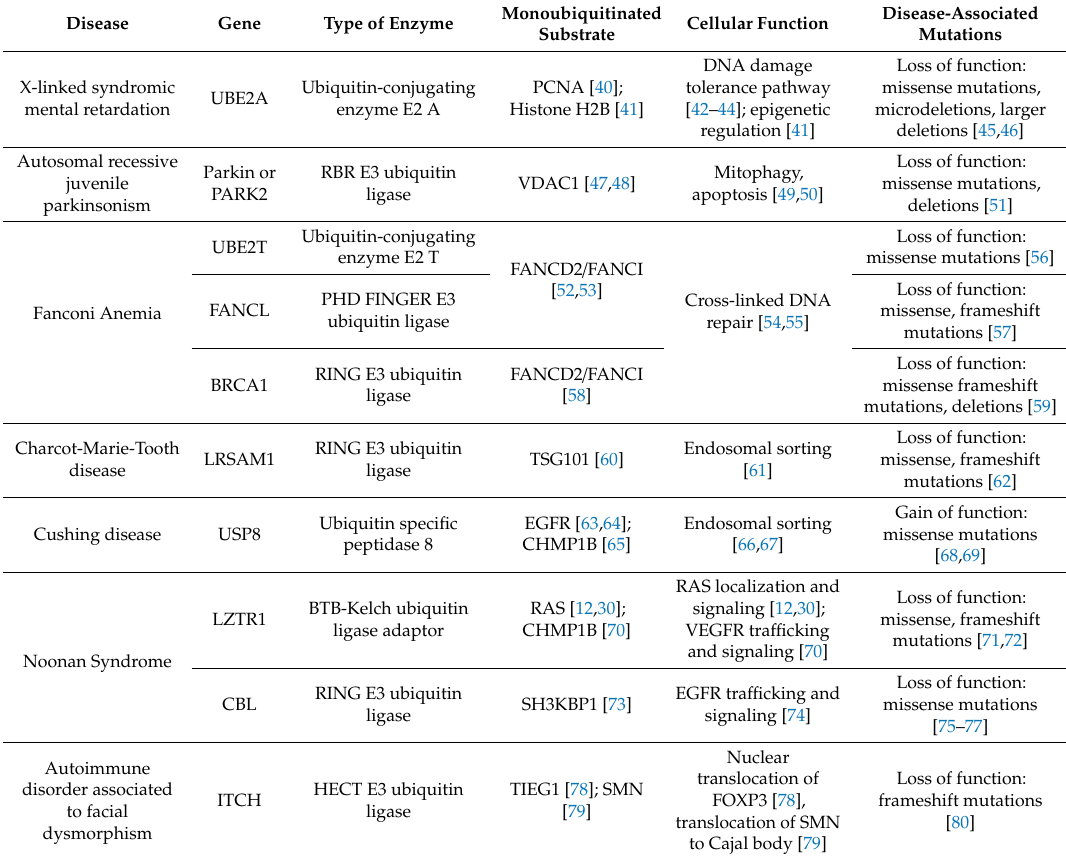
Table 1. Genetic diseases associated with genes regulating monoubiquitination. Short list of substrates modified by the indicated E2 conjugating enzymes, E3 ligases, and ubiquitin hydrolases (DUBs) are shown, together with the indication of the modulated cellular functions and the type of mutations detected in